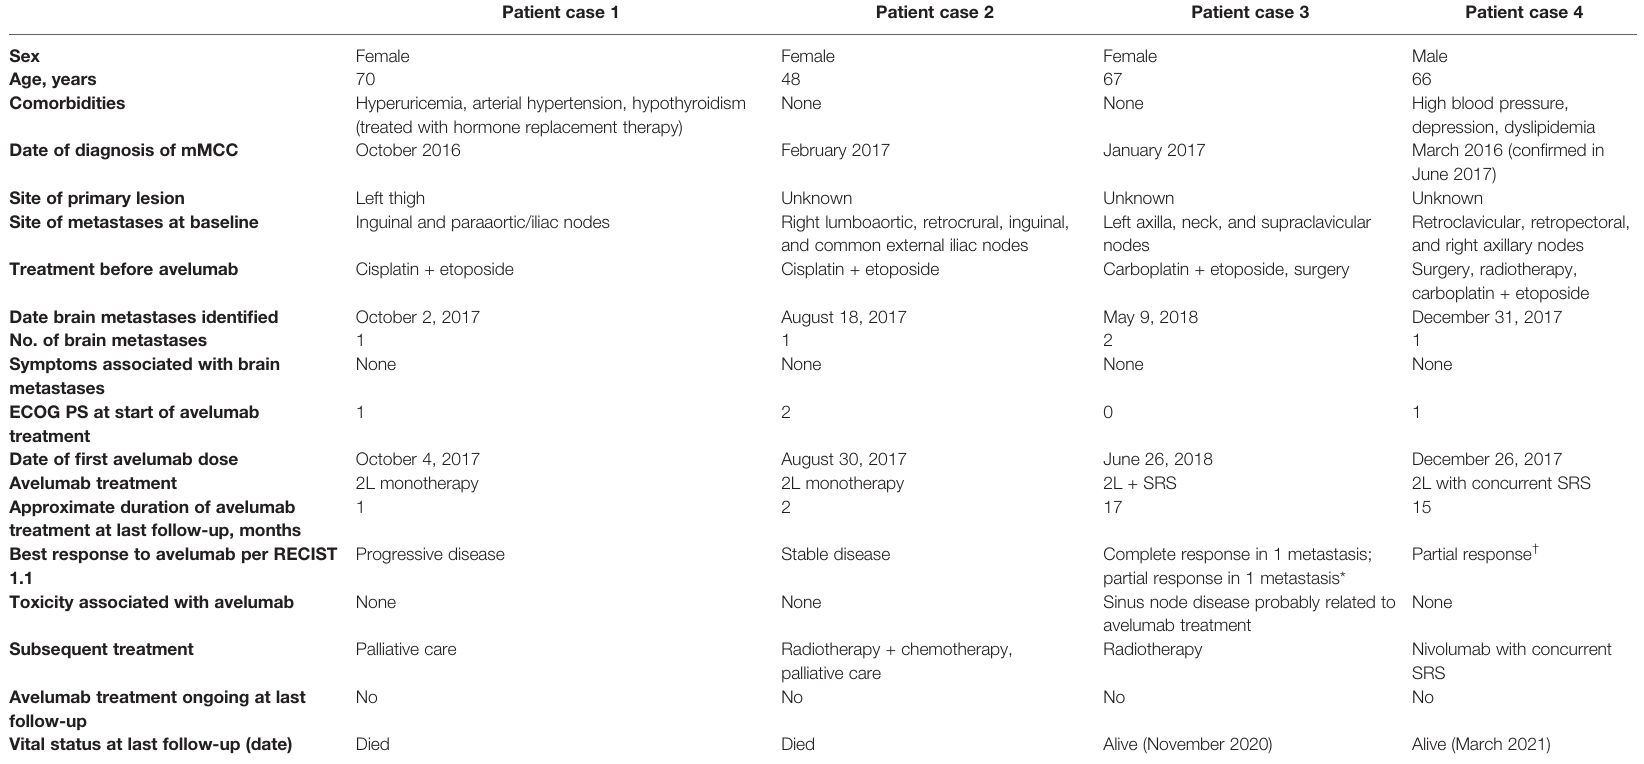
TABLE 1 | Summary of patient